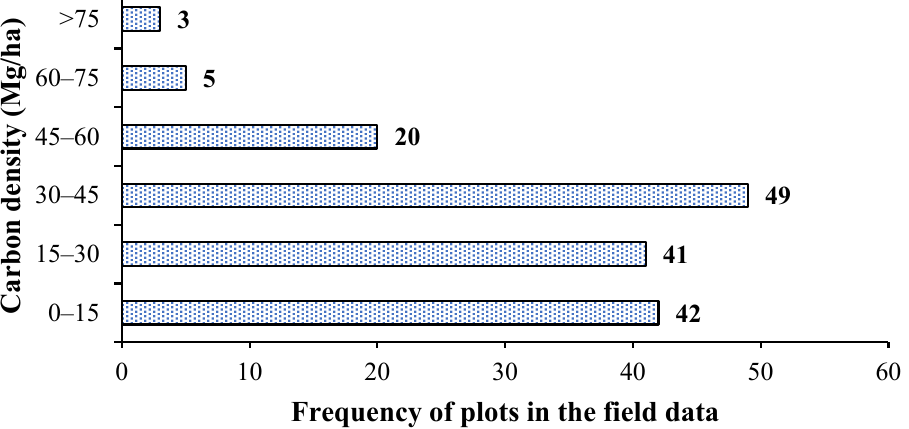
Figure 2. Graphs depicting the carbon-density range and frequency of plots in the study area.